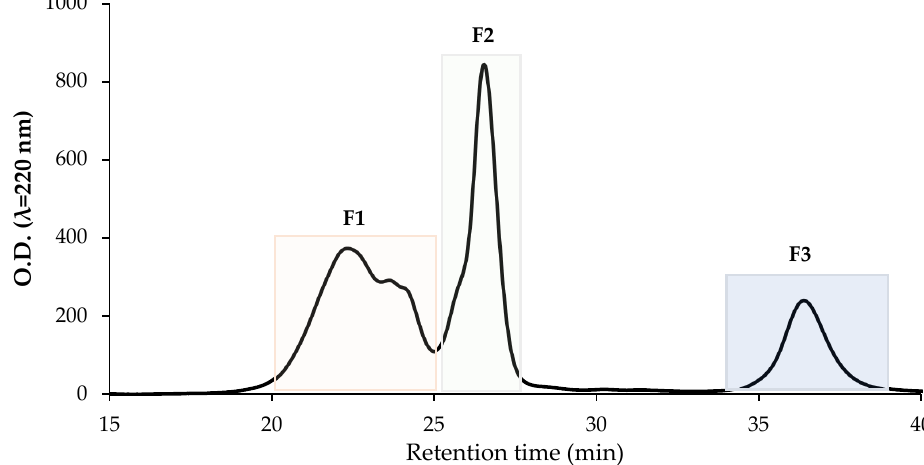
Figure 9. Peptide fractionation of the 3 kDa permeate of Fabelle in vitro gastrointestinal digestate by size exclusion HPLC. F1, fraction 1; F2, fraction 2; F3, fraction 3